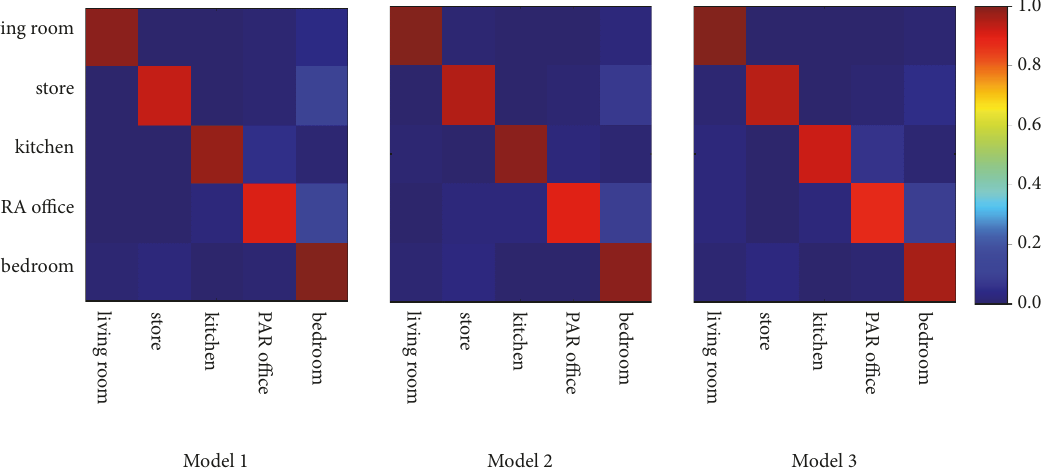
Figure 9: Scene classification test confusion matrixes by the models trained on Scene 15